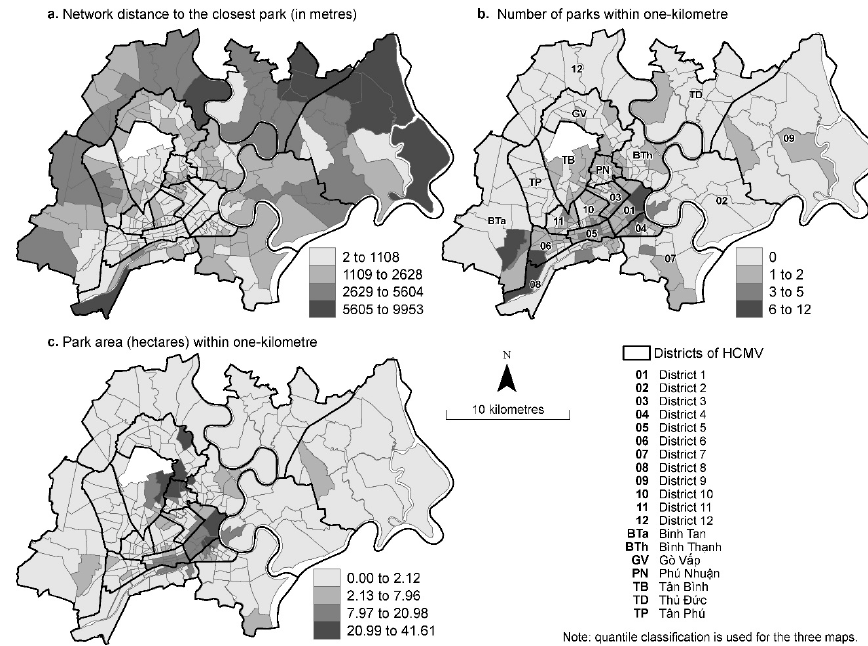
Figure 5. Accessibility to parks by wards in HCMC.